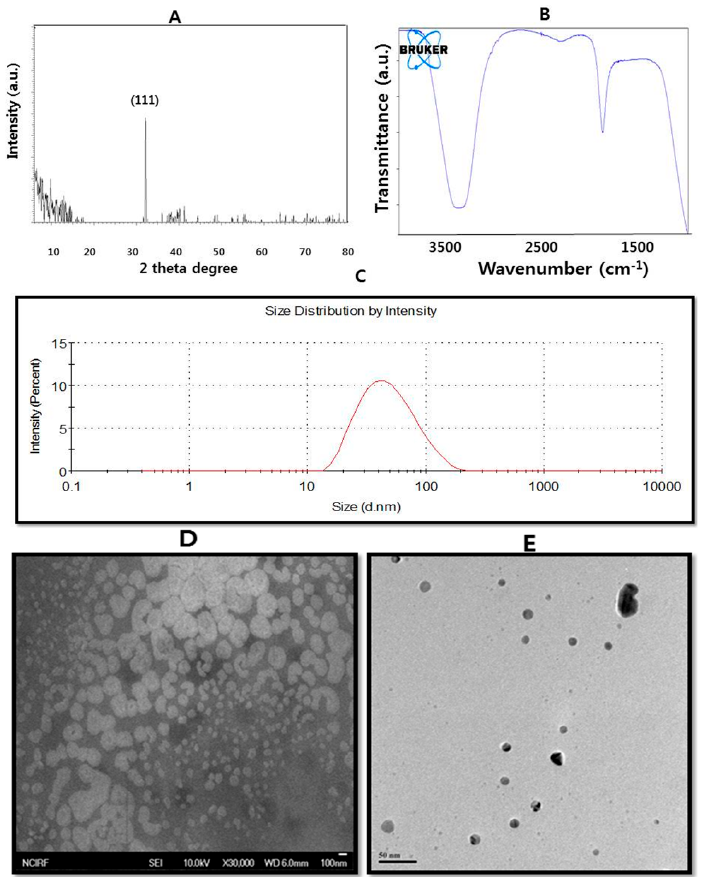
Figure 1. Characterization of silver nanoparticles (AgNPs) prepared from Bacillus species using various analytical techniques. ( A ) Characterization of AgNPs by X-diffraction spectra of AgNPs; ( B ) Fourier transform infrared spectra of AgNPs; ( C ) Measurement of size distribution of AgNPs by dynamic light scattering; ( D ) Scanning electron microscopy images of AgNPs; ( E ). Transmission electron microscopy images of AgNPs.